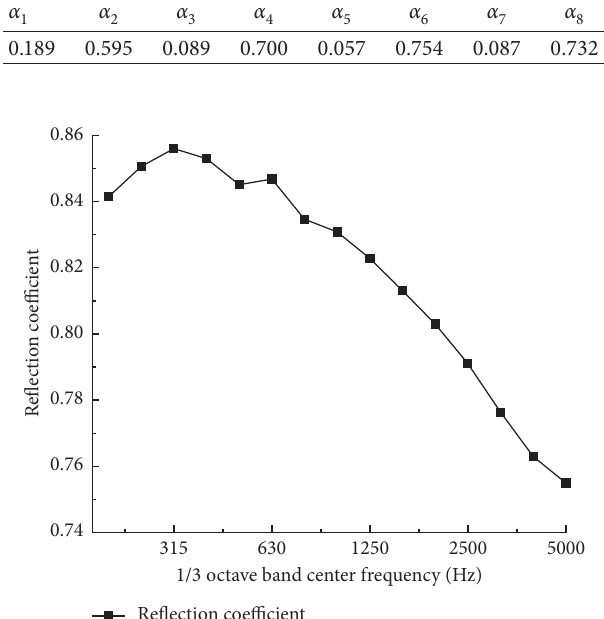
Figure 4: Reflection coefficient in the frequency range of site soil in the